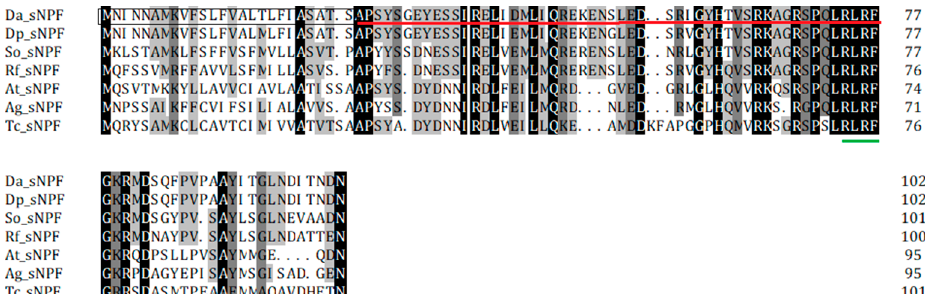
Table 2. Amino acid identity of sNPF and sNPFR genes isolated from D. armandi with related gene sequences in other insects.